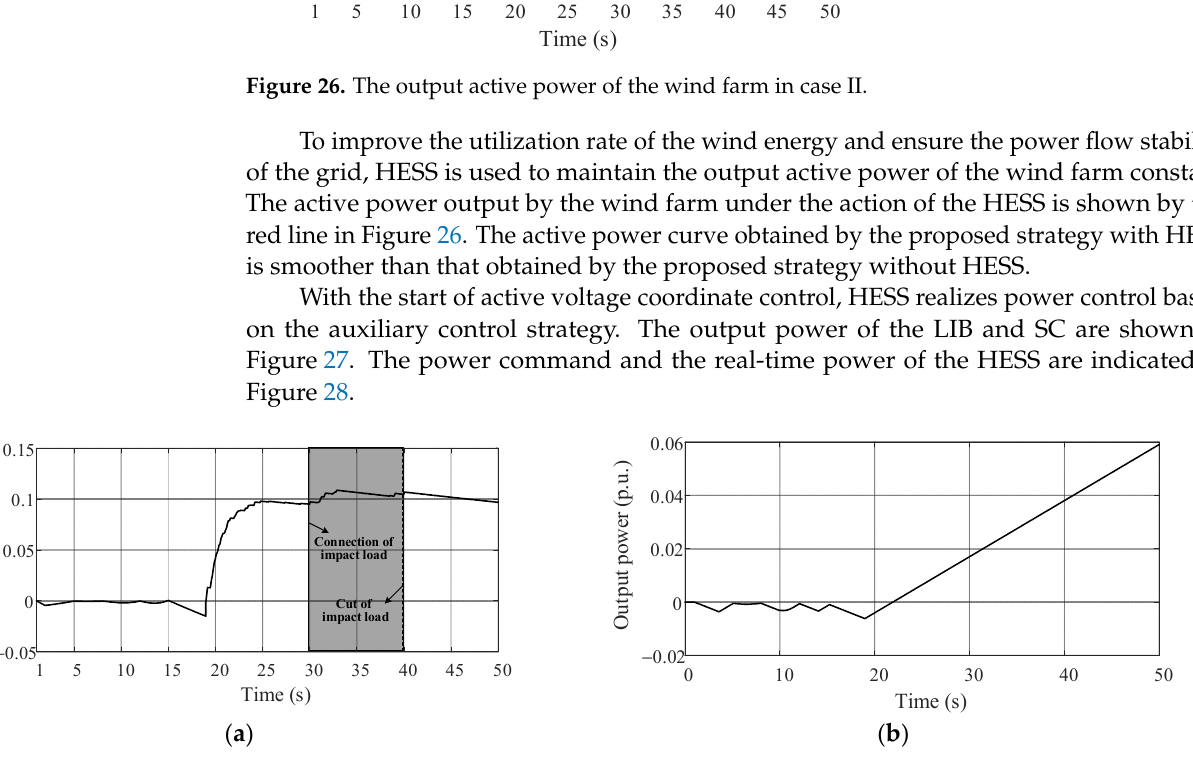
Figure 27. The output power of LIB and SC in case II. ( a ) Output power of LIB. ( b ) Output power of SC .